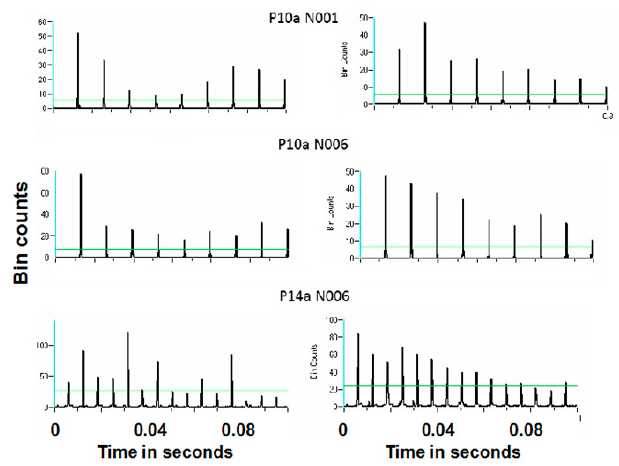
Figure 17. Representative interspike interval histogram of a antidromic-only spike train and its randomized-only spike train counterpart for 30 pps DBS.